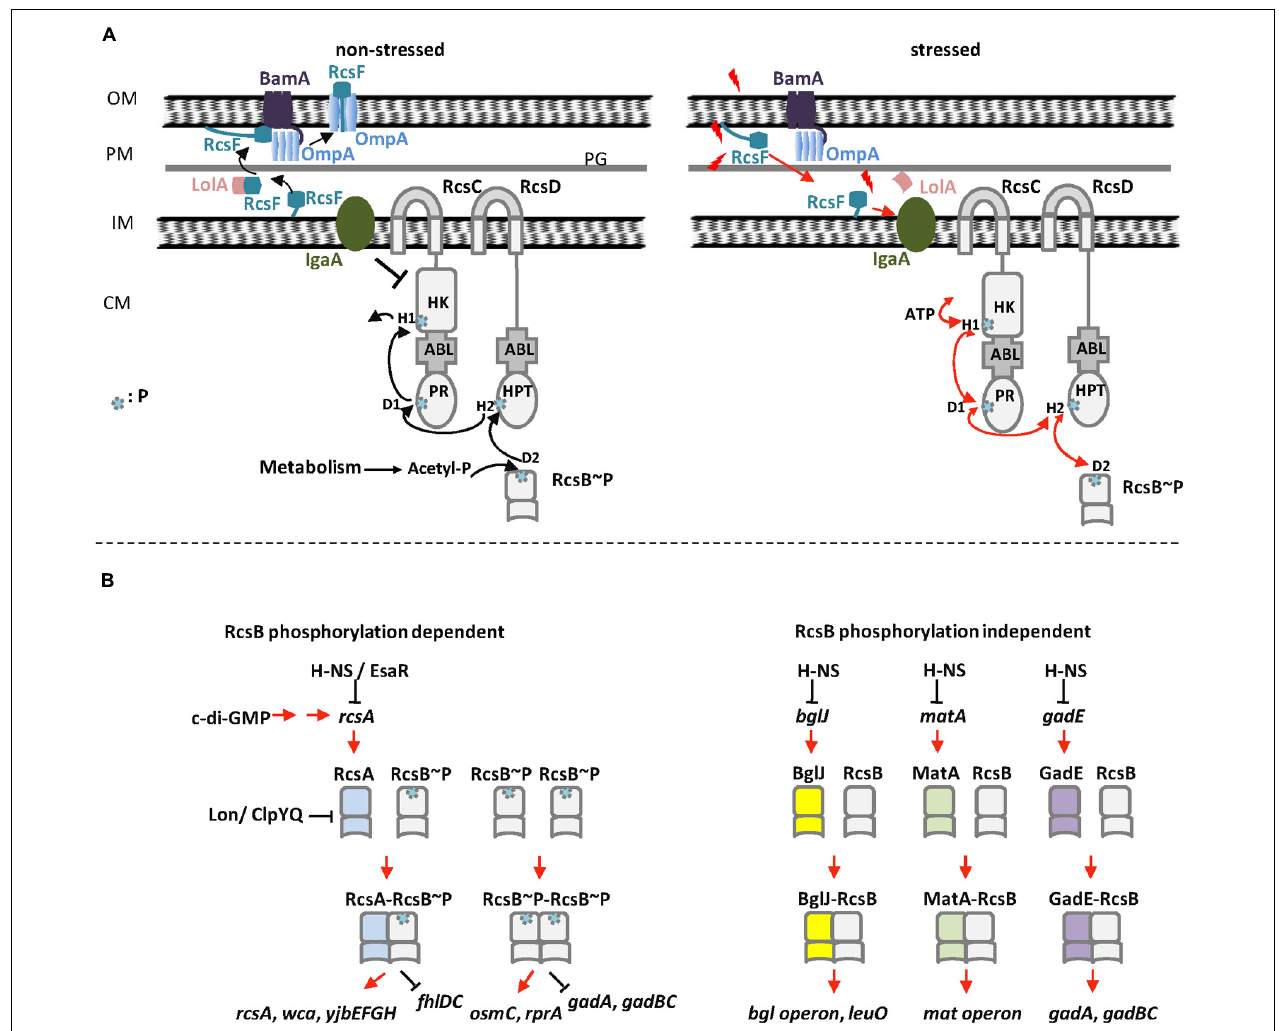
FIGURE 1 | The Rcs phosphorelay system in E . coli . (A) Regulation of RcsB phosphorylation in E . coli . Left: in the absence of stress, RcsF is funneled by BamA and sequestered by OmpA as a surface-exposed protein. YrfF (IgaA in S . enterica serovar Typhimurium) inhibits the kinase activity of RcsC, resulting in dephosphorylation of RcsB. In this situation, AcP might act as a phosphoryl group donor to keep a low level of RcsB phosphorylation. Right: in the presence of stress, RcsF does not interact with BamA and OmpA but interacts with IgaA that release the inhibition of YrfF (IgaA in S . enterica serovar Typhimurium). RcsC autophosphorylates at the H1 position of its HK domain in an ATP-dependent manner. The phosphoryl group is then transferred to D1 on the PR domain of RcsC, then to H2 on the HPt domain of RcsD and finally to RcsB. (B) The homo- and heterodimers of RcsB in E . coli . Left: RcsB forms homodimer or heterodimer with RcsA to regulate target genes in a phosphorylation dependent manner. Right: RcsB forms heterodimer with BglJ, GadE, or MatA to regulate target genes in a phosphorylation independent manner. OM, outer membrane; PM, periplasm; IM, inner membrane; CM, cytoplasm; PG, peptidoglycan; P, phosphoryl